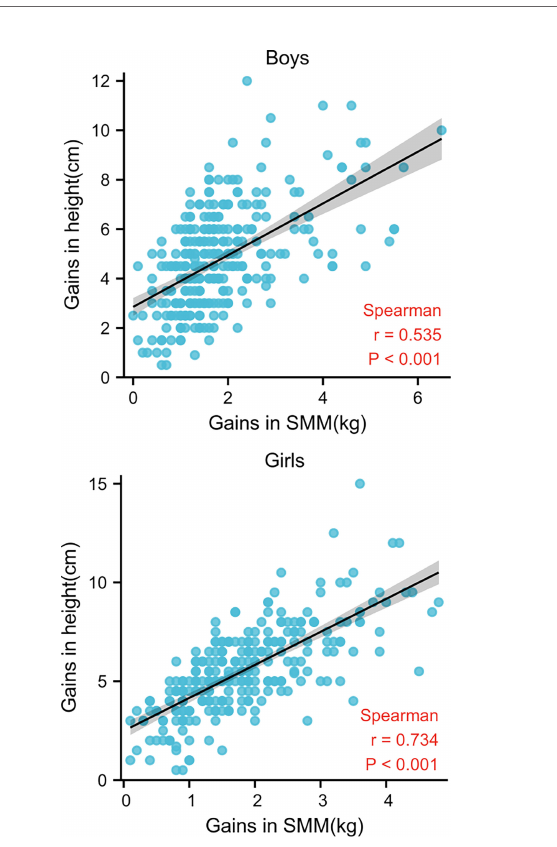
FIGURE 2 | Spearman ’ s correlation between gains in height and SMM in both sexes.